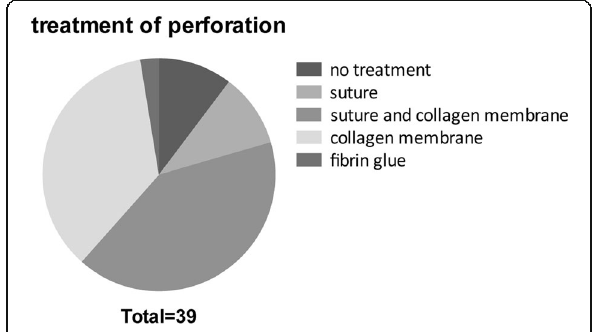
Fig. 2 Overview of the perforation treatment in the study group Fig. 3 Reasons for